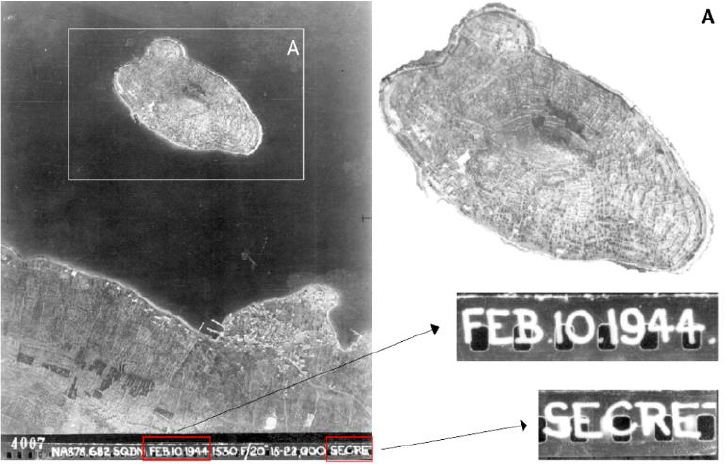
Figure 6. Original, raw (non-referenced) aerial photograph from 1944.